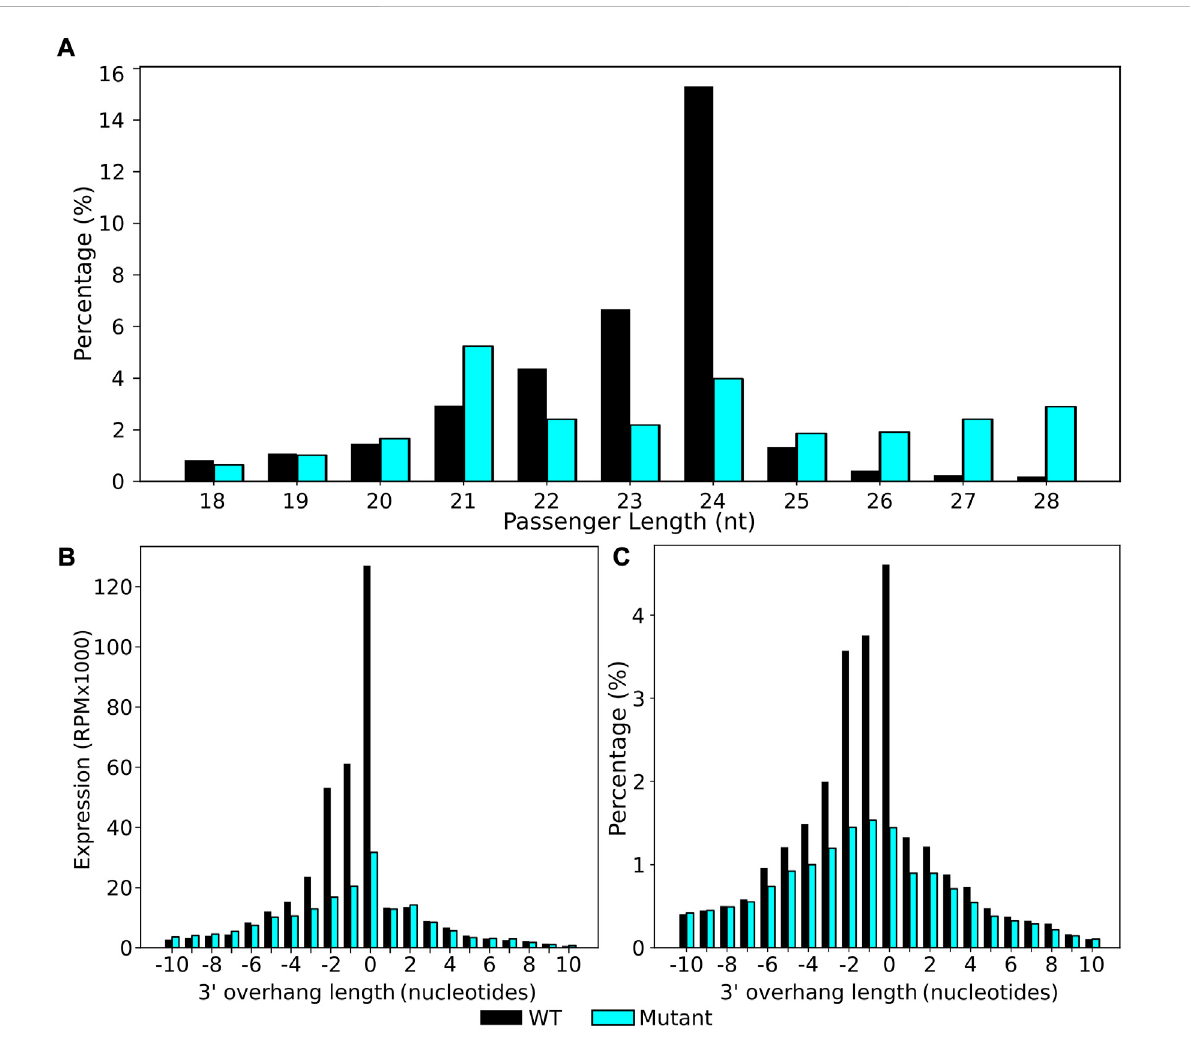
FIGURE 5 stepRNA predicts that A. thaliana 24 nt sRNAs form duplexes with other 24 nt sequences with a 3 ′ Dicer cleavage signature. 24nt sRNA reads wereextractedfromrawdataandanalysedwithstepRNA.Allrawreadswereusedaspotentialpassengerstrandstoidentifythemostlikelypassenger strand length and Dicer cleavage signatures. Bar graphs showing (A) the predicted passenger strand lengths of wild-type (black) and dcl2dcl3dcl4 mutant (blue) strains, (B) sRNA expression of sRNAs in duplexes and the3 ′ overhang length in the predicted sRNA duplex, (C) the percentage